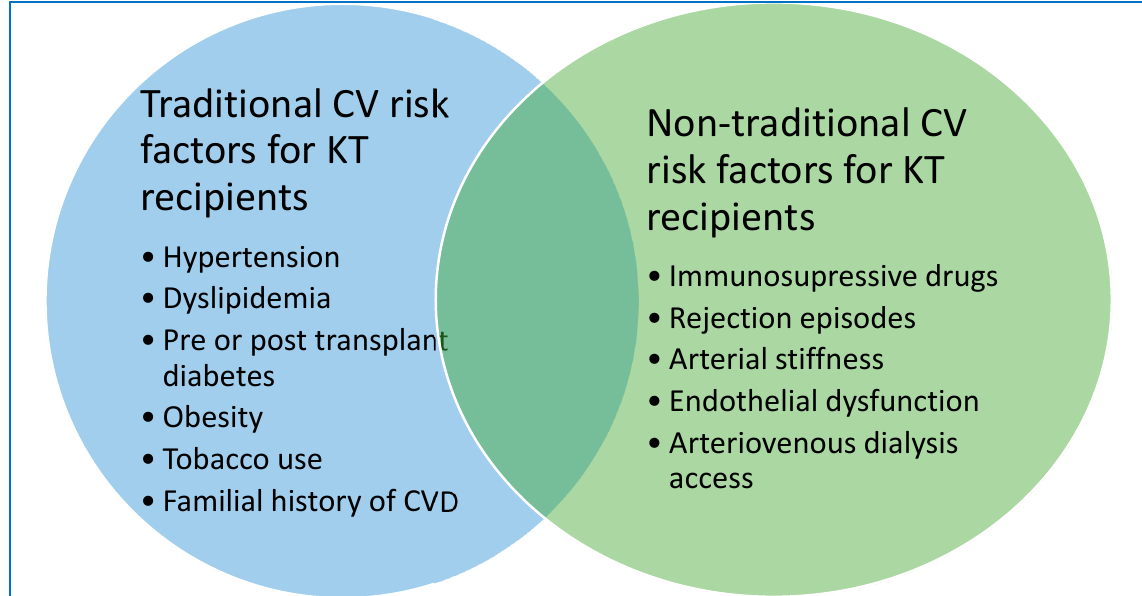
Figure 1. Traditional and non-traditional CV risk factors in KT recipients.